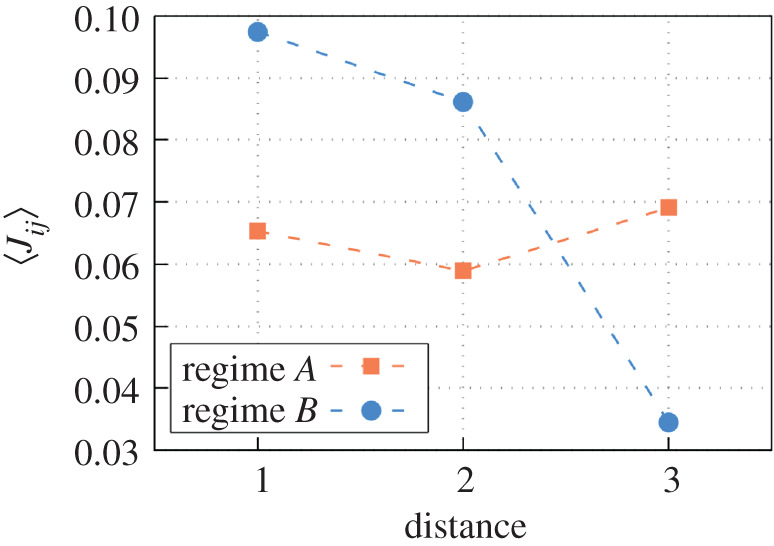
Averaged pairwise interactions (Jij) between the nodes i and j by distance for regimes A and B.